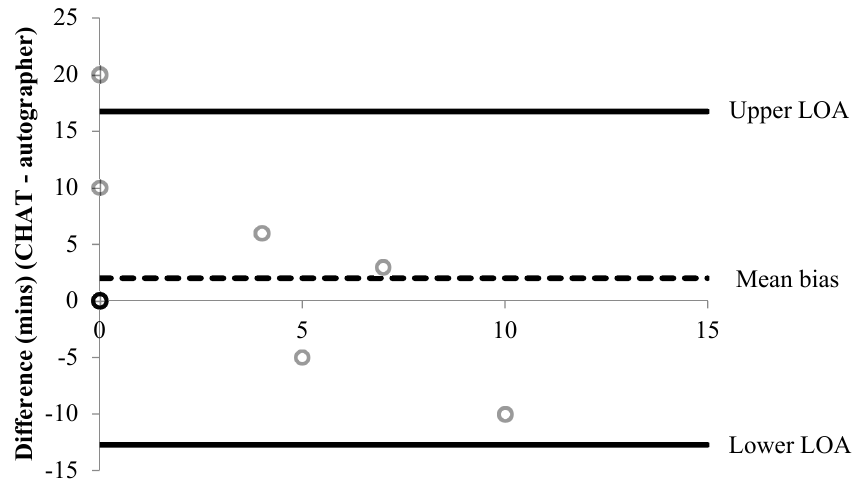
Figure 5. Bland–Altman plot demonstrating the difference between self-reported and autographer- derived homework and reading duration before school ( n = 12). Six data points overlap shown by the darker outline. A mean bias of +2 min (±8 min) with LOA of +17 and − 13 min is shown.